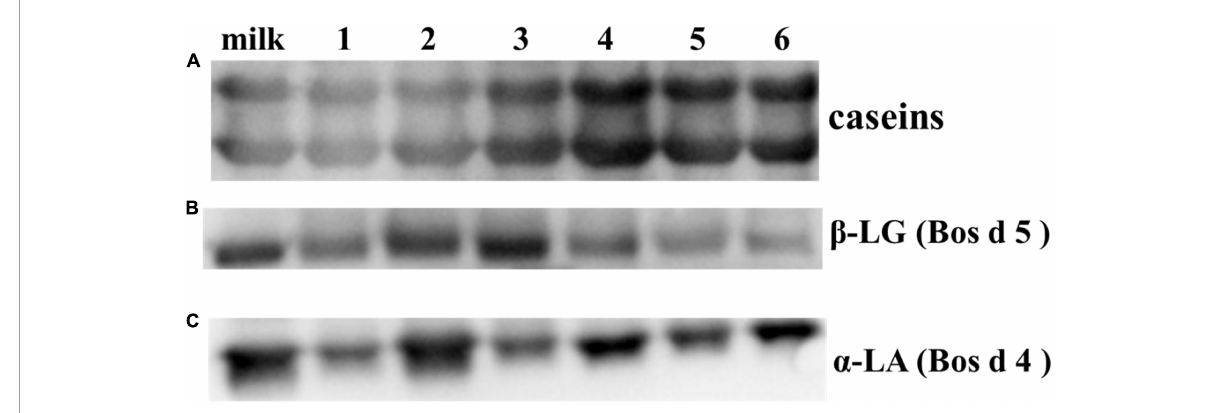
FIGURE3 Western blot analysis detected IgG binding ability of main allergens (A) caseins; (B) Bos d 5; (C) Bos d 4 in yogurts by using anti-caseins/Bos d 5/Bos d 4 specific sera of rabbit.